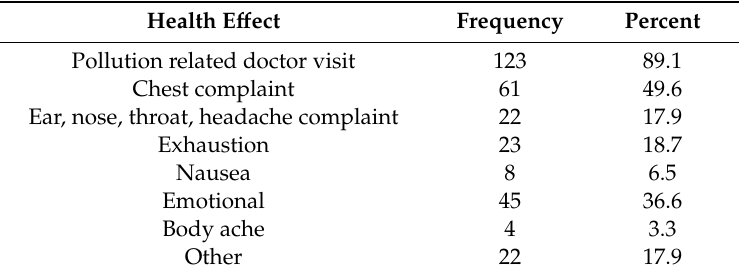
Table 4. Health-related pollution impacts.